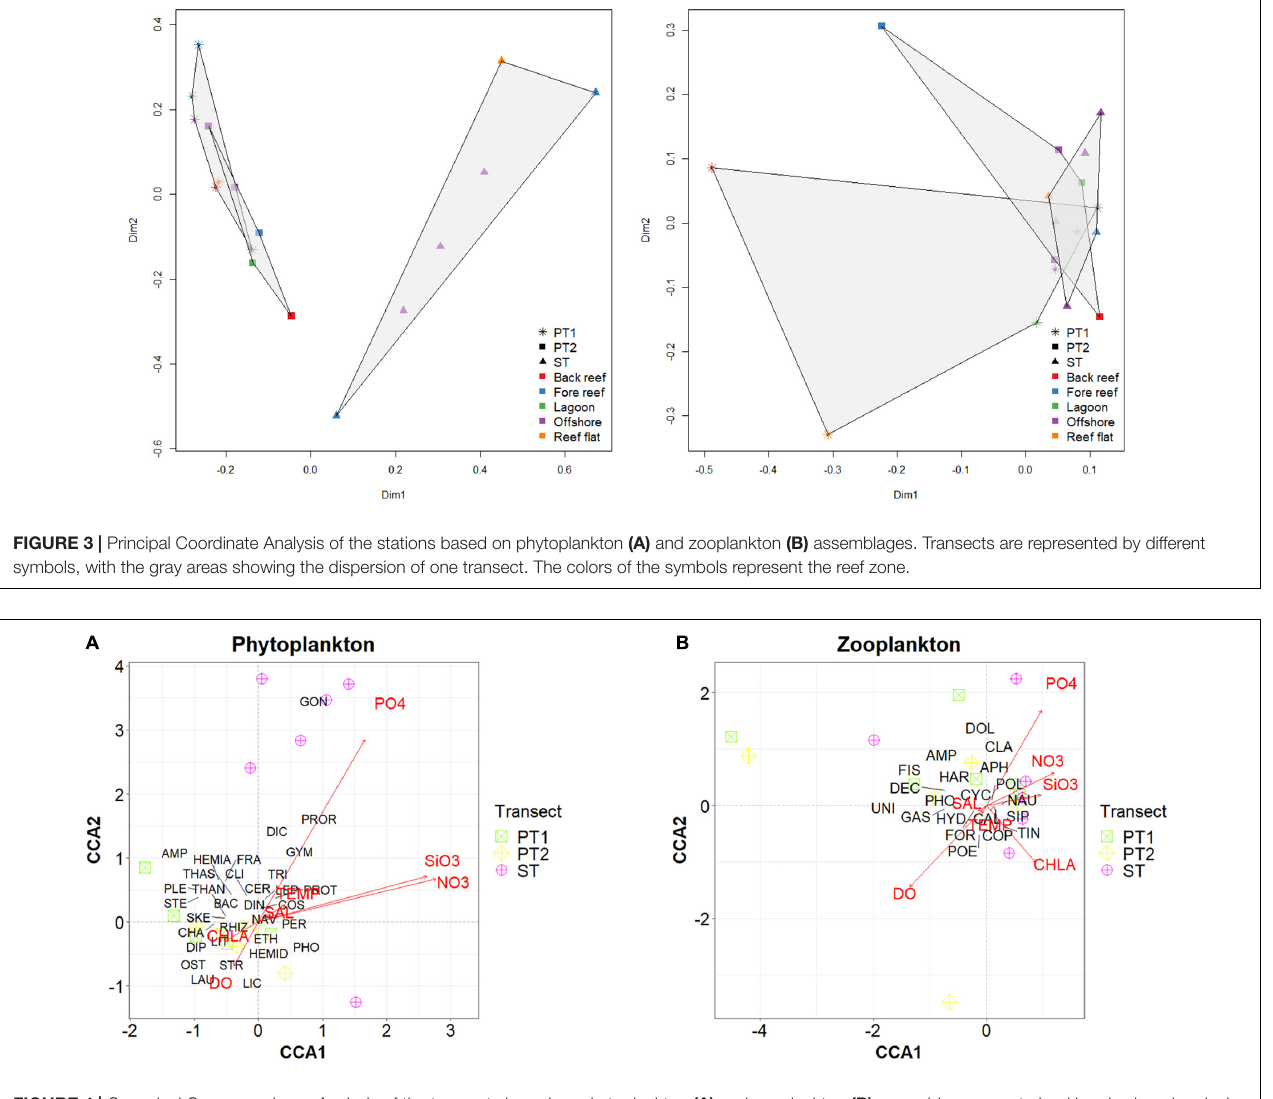
FIGURE 4 | Canonical Correspondence Analysis of the transects based on phytoplankton (A) and zooplankton (B) assemblages constrained by physico-chemical parameters. Transects are represented by different symbols. Text labels represent taxa. For phytoplankton taxa - AMP, Amphisoleniaceae; BAC, Bacillariaceae; CER, Ceratiaceae; CHA, Chaetocerotaceae; CLI, Climacospheniaceae; COS, Coscinodiscaceae; DIC, Dictyochaceae; DIN, Dinophysaceae; DIP, Diploneidaceae; ETH, Ethmodiscaceae; FRA, Fragilariaceae; GON, Gonyaulacaceae; GYM, Gymnodiniaceae; HEMIA, Hemiaulaceae; HEMID, Hemidiscaceae; LAU, Lauderiaceae; LEP, Leptocylindraceae; LIC, Licmophoraceae; LIT, Lithodesmiaceae; NAV, Naviculaceae; OST, Ostreopsidaceae; PER, Peridiniaceae; PHO, Phormidiaceae; PLE, Pleurosigmataceae; PROR, Prorocentraceae; PROT, Protoperidiniaceae; RHIZ, Rhizosoleniaceae; SKE, Skeletonemaceae; STE, Stephanopyxidaceae; STR, Striatellaceae; THAN, Thalassionemataceae; THAS, Thalassiosiraceae; TRI, Triceratiaceae. For zooplankton taxa - AMP, Amphipoda; APH, Aphragmophora; CAL, Calanoida; CLA, Cladocera; COP, Copelata; CYC, Cyclopoida; DEC, Decapoda; DOL, Doliolida; FIS, Fish larvae; FOR, Forcipulatida; GAS, Gastropoda;